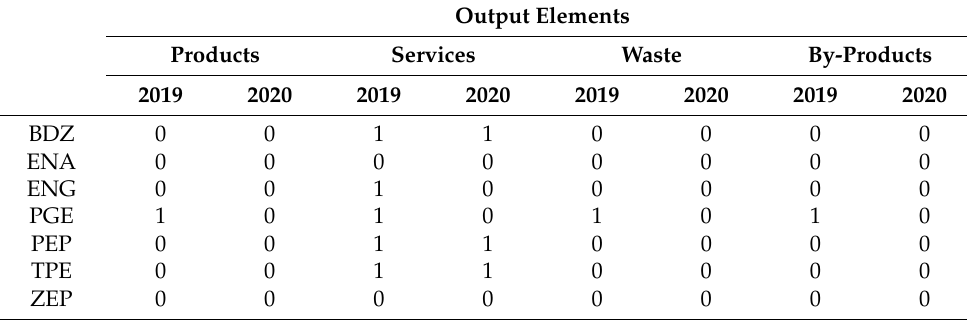
Table 7. Output elements of enterprises in the energy sector for 2019–2020.